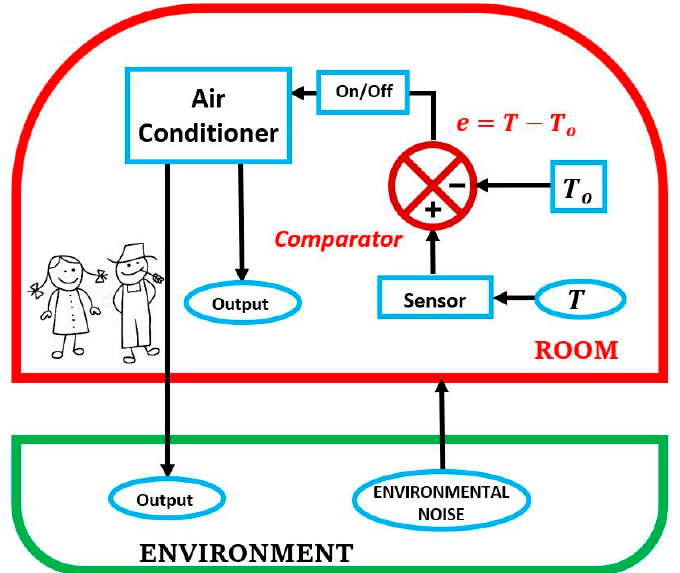
Figure 1. A one-parameter feedback loop simulation of a control mechanism (thermostat) associated with a room air conditioning system.